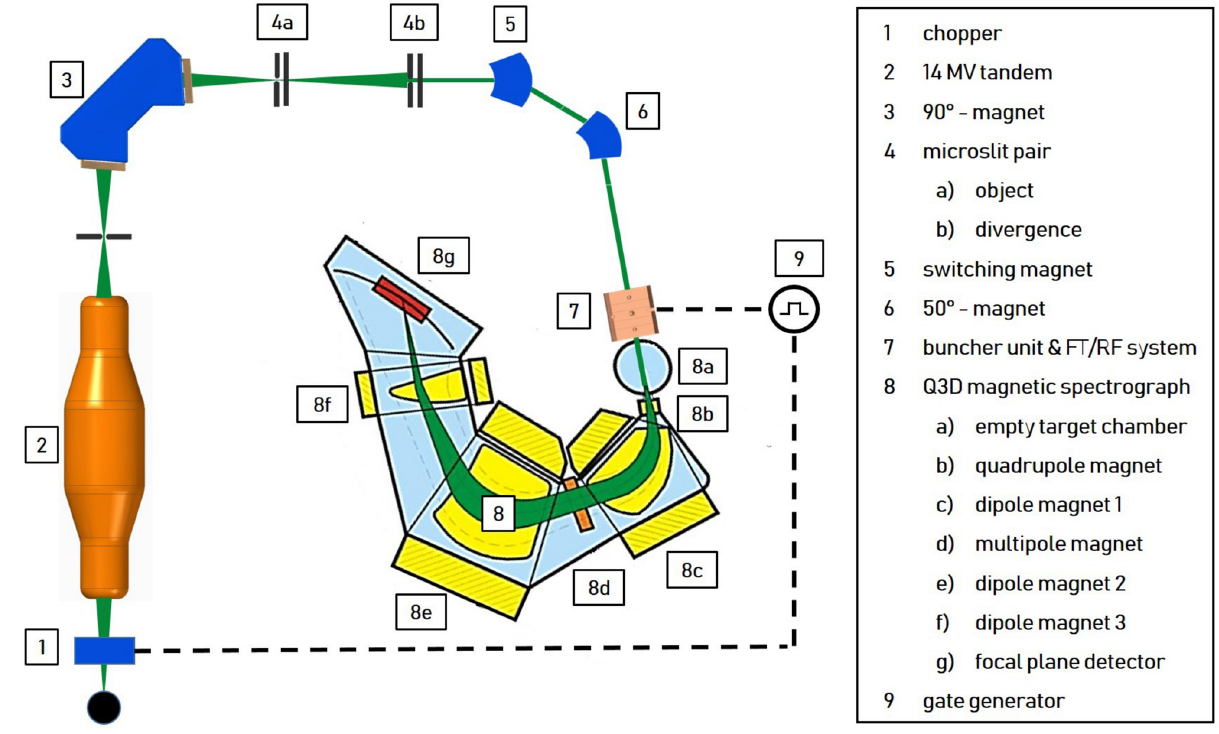
Fig 10. Measurement setup for performance evaluation using a tandem accelerator and a Q3D magnetic spectrograph.